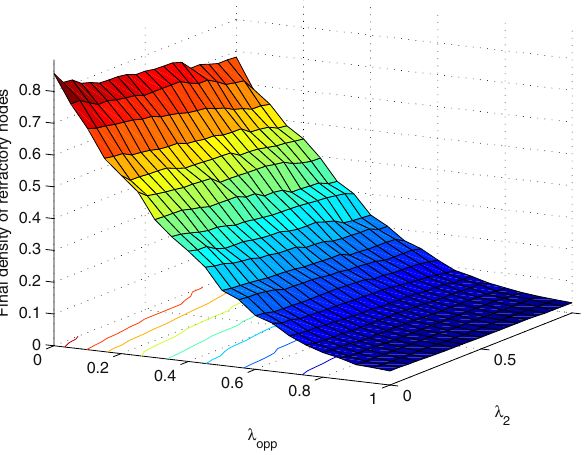
Figure 10. Final density of refractory nodes for information l 1 versus λ 2 and λ opp when the methods of distracting node attention and propagating opposite information are included. λ = 0.8, δ = 0.5 and T =